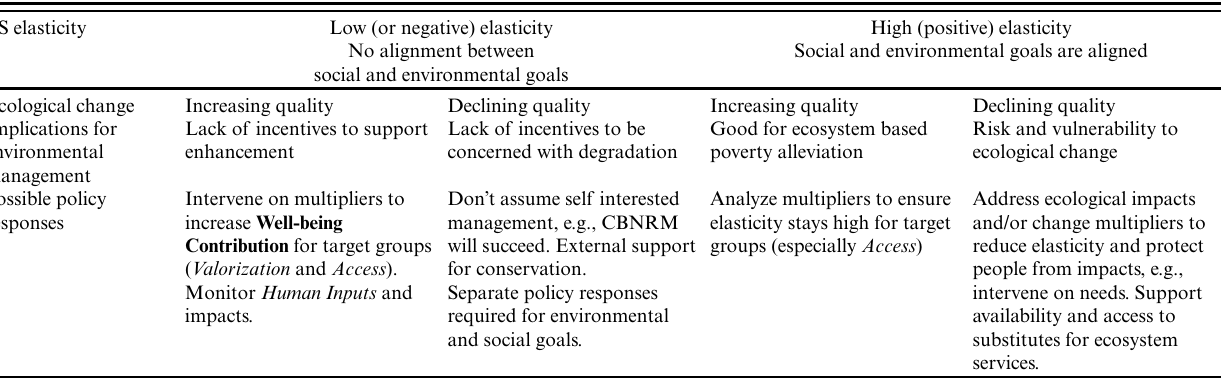
Table 3 . Implications of high and low ES elasticities for policy and environmental management. CBNRM, community-based natural resource